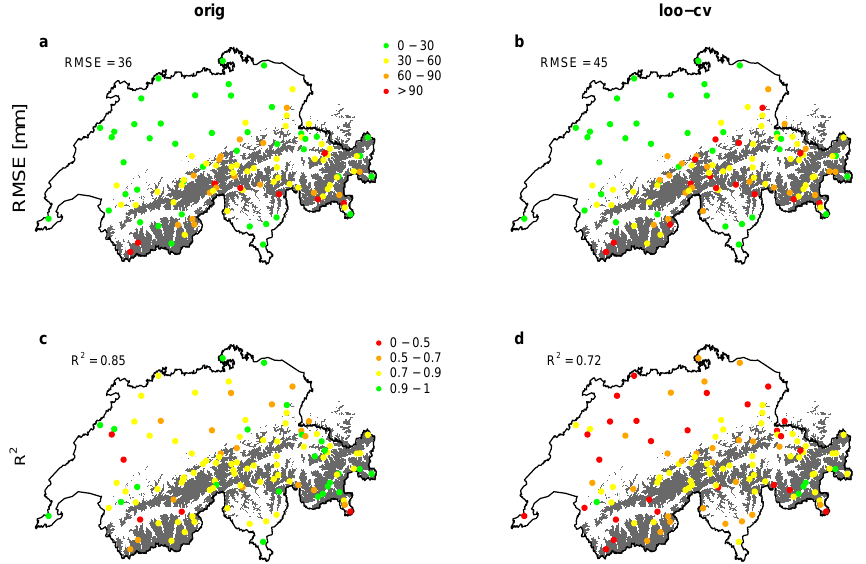
Fig. 4. Statistics for the SWE maps at station grid cells averaged over the period 2001–2009. The scores averaged over all stations are listed in the upper left of each figure. The left column ( a and c ) contains the scores calculated with SWE orig and the right ( b and d ) those based on SWE loo-cv . Areas shaded grey are higher than 2000ma.s.l.